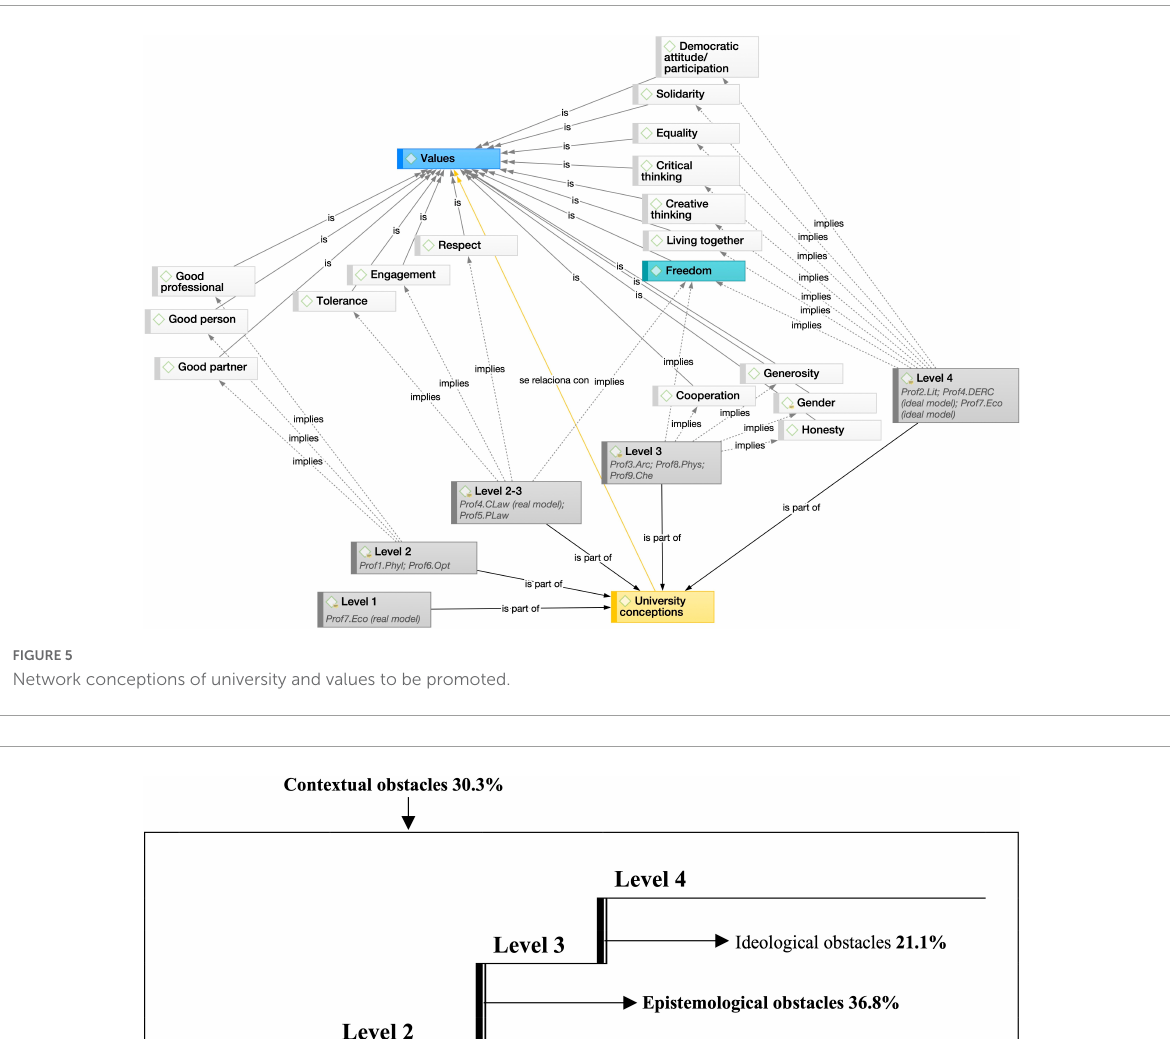
FIGURE6 Reported obstacles between levels of